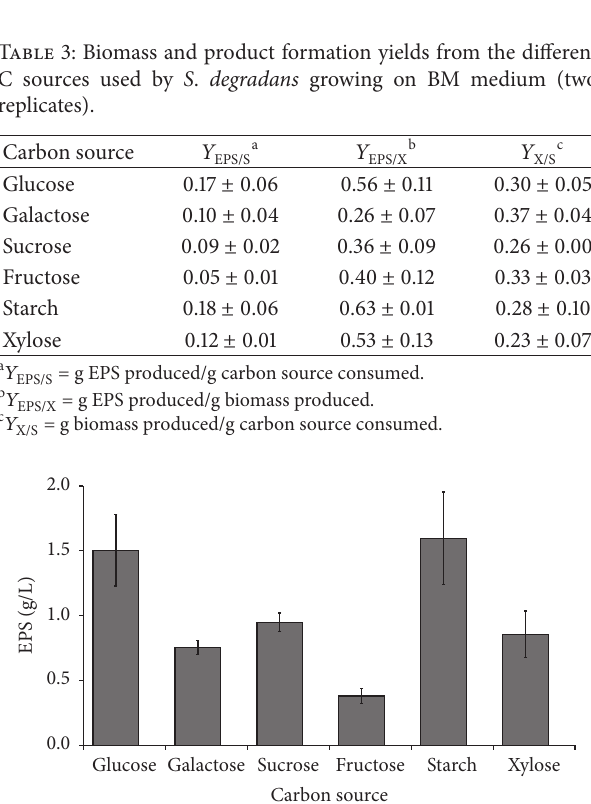
Figure 1: Maximum EPS production from each of the C sources tested in basal medium (BM). The values represent the media of three